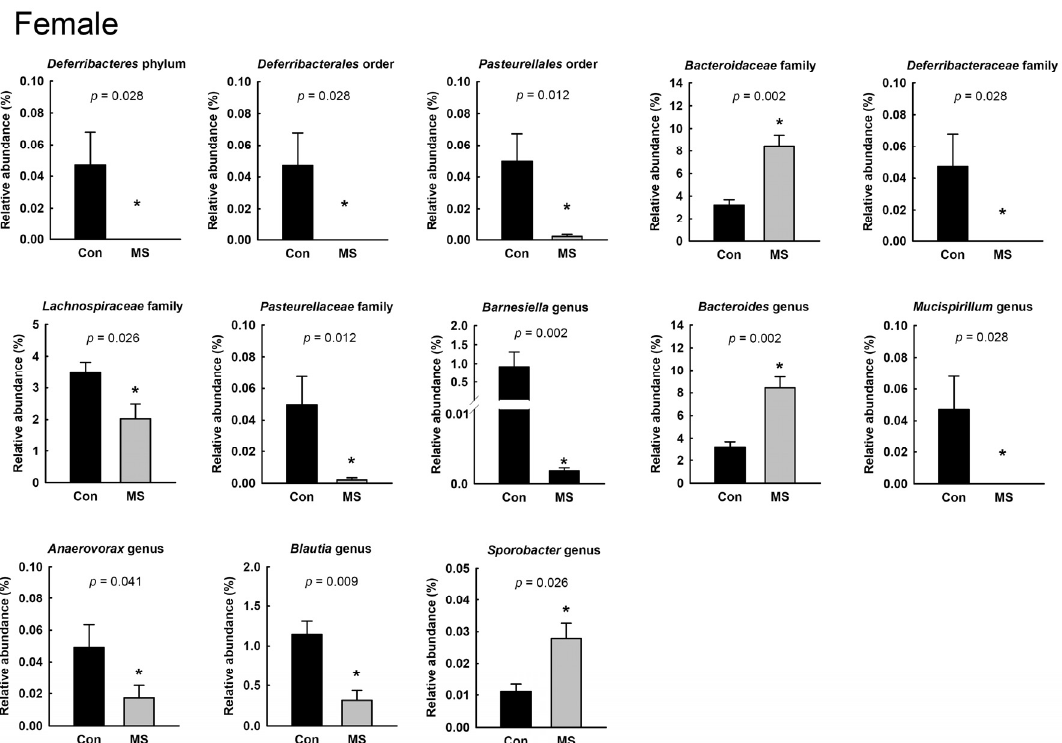
Figure 4. Effect of maternal separation (MS) on fecal microbiota composition in female rats. Taxa whose relative abun- dances are significantly changed by MS. Data are mean ± SEM. The abundance of Deferribacteres, Deferribacterales, Deferribacteraceae and Mucispirillum was not detected in MS rats. Wilcoxon rank-sum test, * p < 0.05. n = 6 per group.